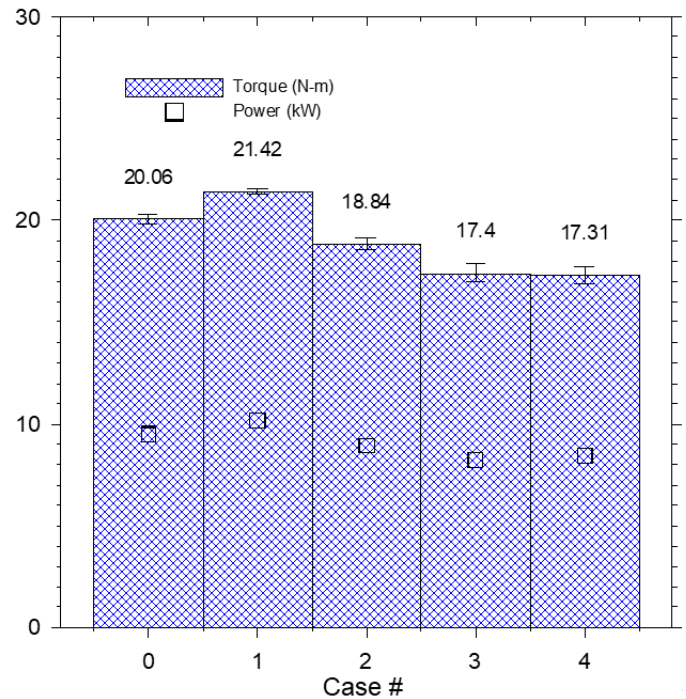
Figure 6. Power and torque output for different valve settings.